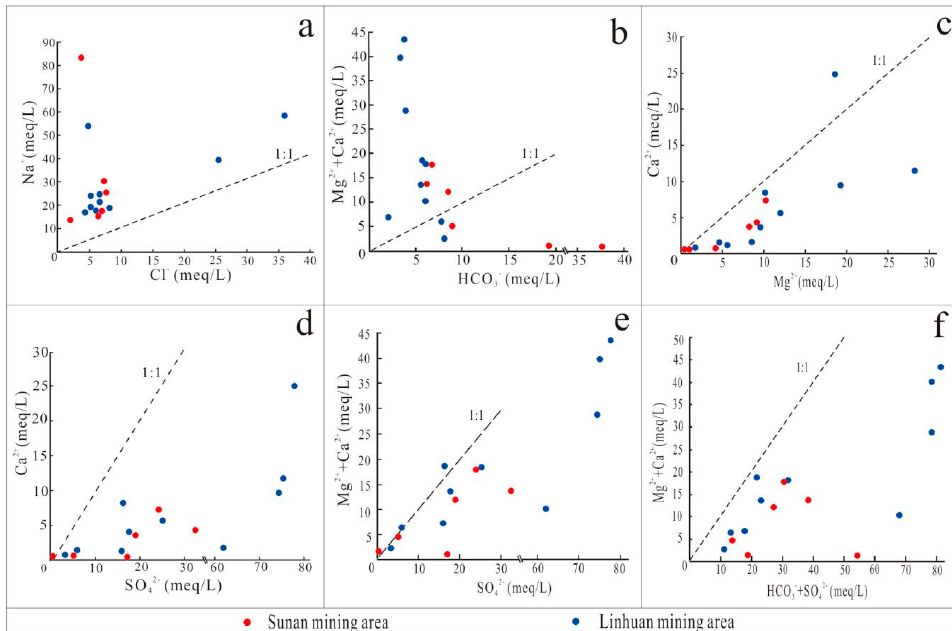
Figure 8. Molar ratio diagram of the Taiyuan formation limestone water ions in the study area. (Na + and Cl − （ a ）， Mg 2+ +Ca 2+ and HCO 3 − （ b ）， Ca 2+ and Mg 2+ （ c ）， Ca 2+ and SO 42- （ d ）， Mg 2+ + Ca 2+ and SO 42 − （ e ）， Mg 2+ +Ca 2+ and HCO 3 − +SO 42 − （ f ） )